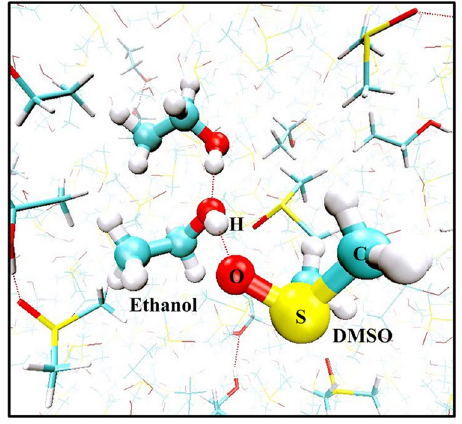
Figure 3. Snapshot of part of the simulation box corresponding to = E zero showing DMSO-ethanol and max ethanol-ethanol hydrogen bonds. For better visualization, one of the DMSO molecules along with the nearest hydrogen-bonded ethanol molecule is shown in CPK representation; other DMSO and ethanol molecules are represented in licorice and line styles, respectively. The picture was generated with the help of VMD package.